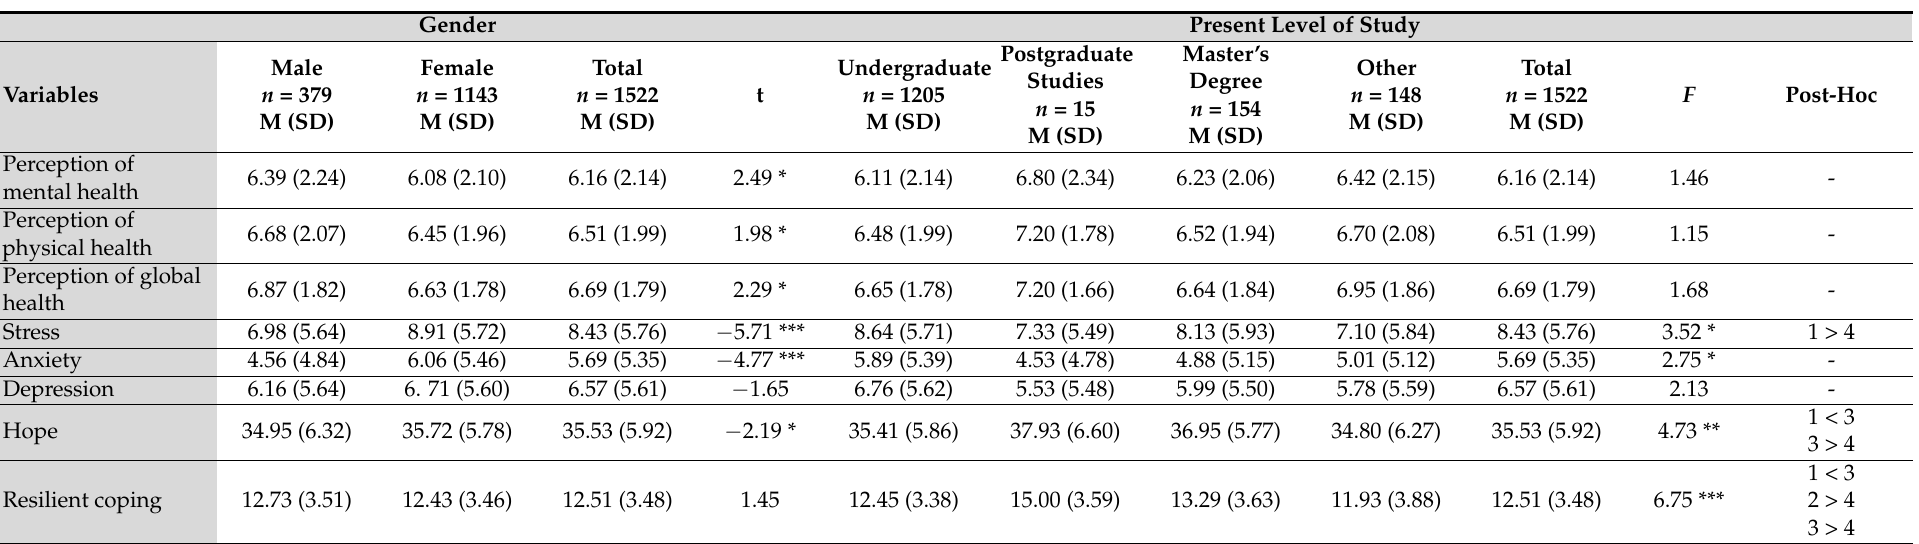
Table 3. Comparisons between health-related perceptions, mental health symptoms, and psychological factors, according to the student’s characteristics (gender and level of